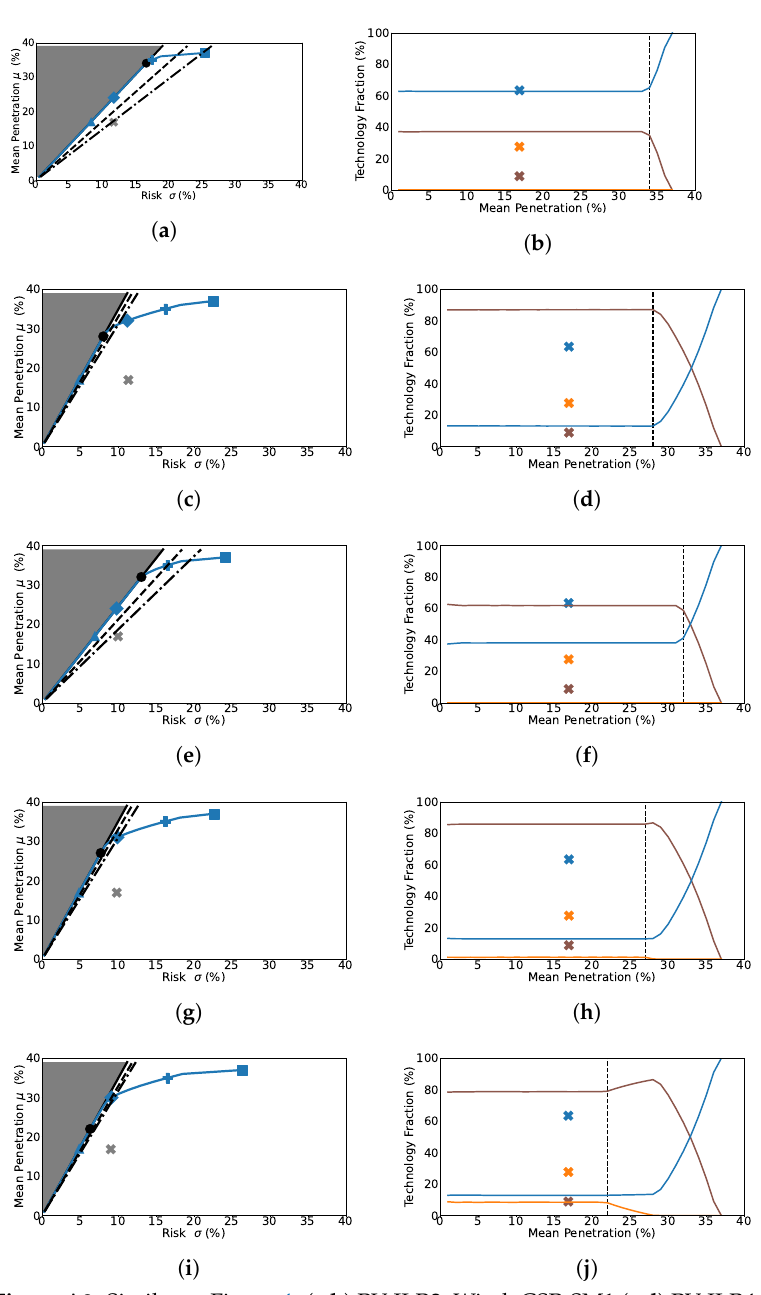
Figure A3. Similar to Figure 4. ( a , b ) PV-ILR2–Wind–CSP-SM1 ( c , d ) PV-ILR4–Wind–CSP-SM1 ( e , f ) PV-ILR3–Wind–CSP-SM2 ( g , h ) PV-ILR4–Wind–CSP-SM2 ( i , j ) PV-ILR4–Wind–CSP-SM3. Scenarios with unlimited storage capacity and